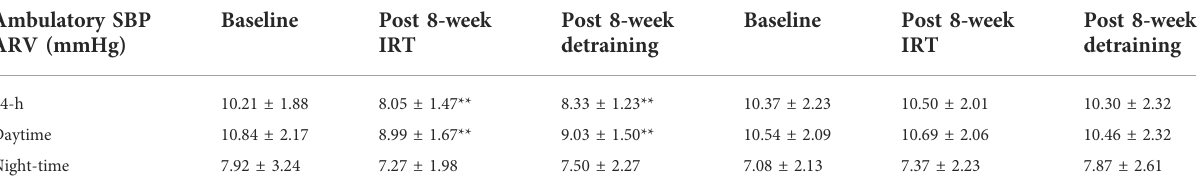
TABLE 2 Ambulatory SBP ARV results at baseline, post 8-week IRT and post 8-week detraining TRG-DT control. Ambulatory SBP ARV